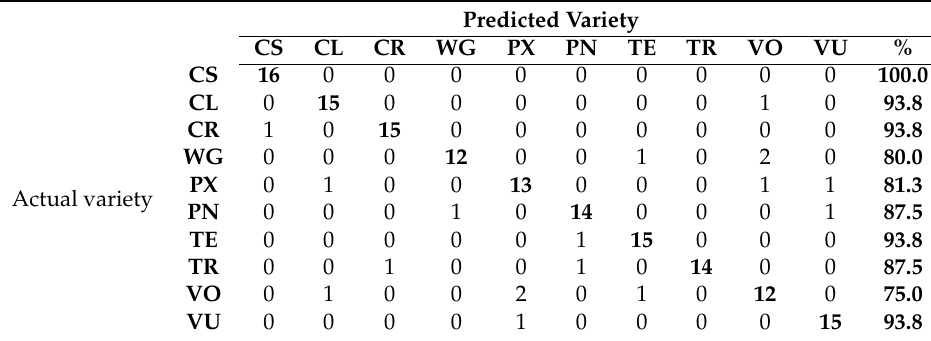
Table 1. Confusion matrix of grapevine varietal classification using support vector machines and a 5-fold cross-validation. The diagonal of the matrix corresponds to the number of samples that were properly classified. The last column displays, for each variety, the correctly classified percentage (n = 159).